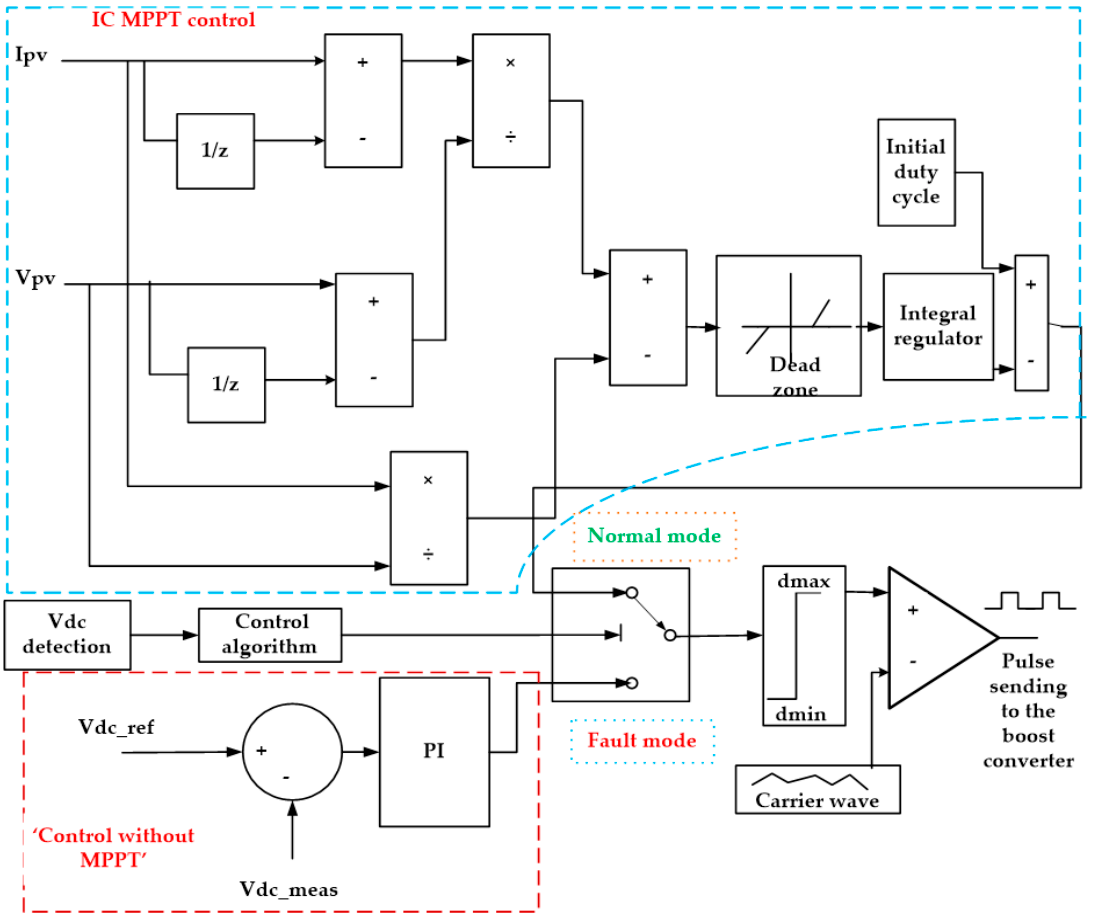
Figure 4. Proposed DC-link voltage control.